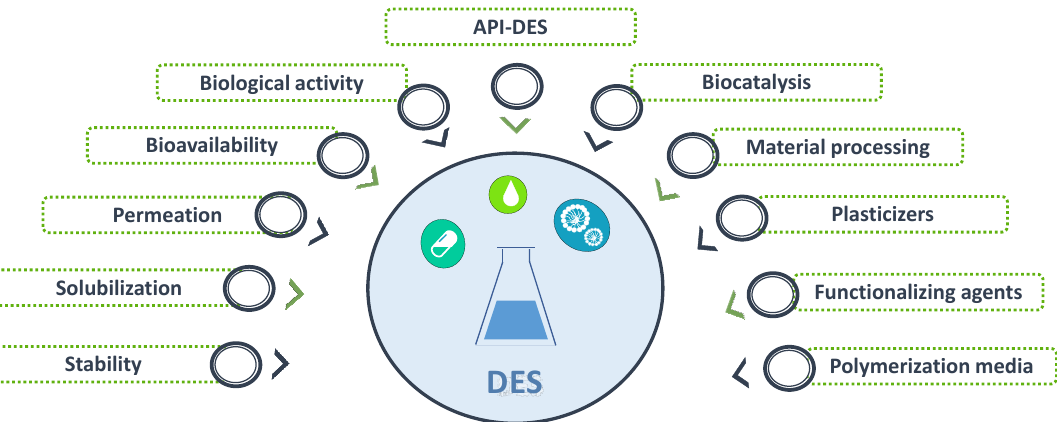
Figure 2. Different applications of DES within the pharmaceutical field.